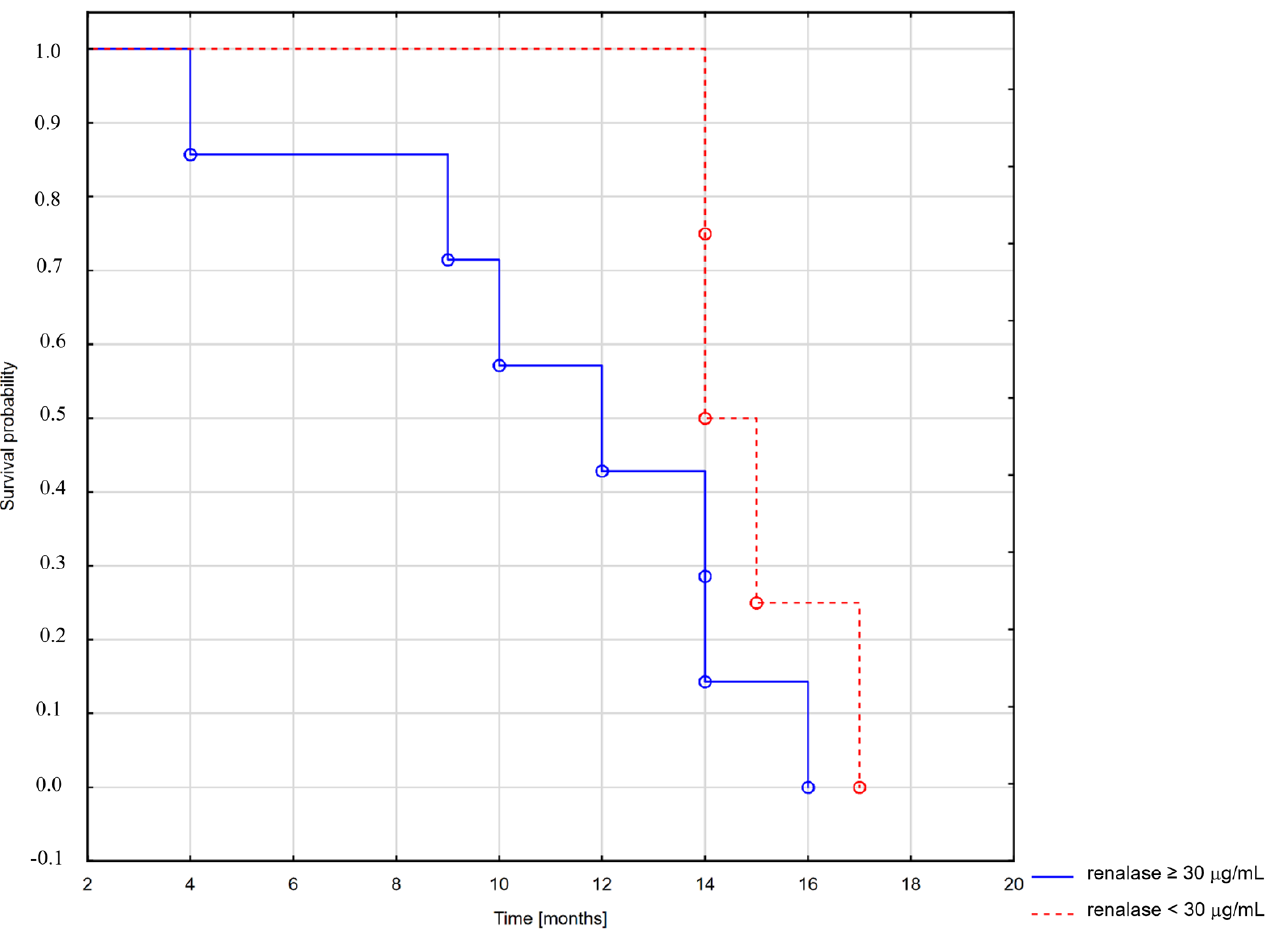
Figure 4. Kaplan–Meier curve for all-cause death in groups with low and high renalase Figure 4. Kaplan – Meier curve for all-cause death in groups with low and high renalase levels.